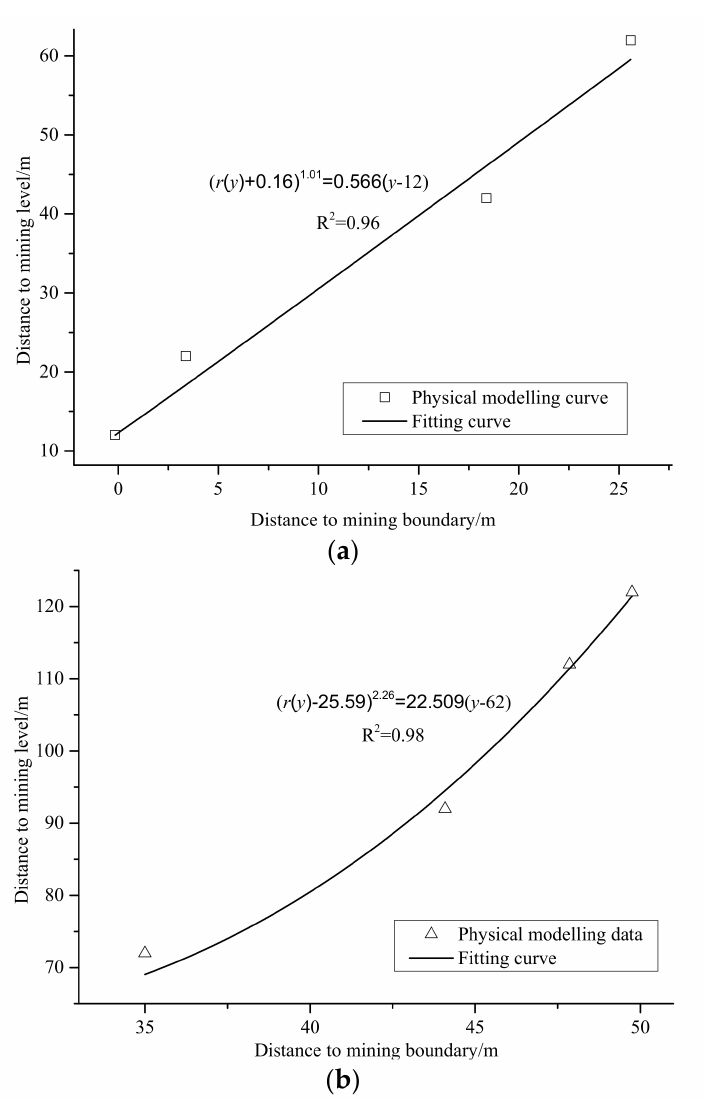
Figure 10. Movement boundary equation of bedrock and unconsolidated stratum in physical simulation. ( a ) Movement boundary in bedrock; ( b ) Movement boundary in unconsolidated